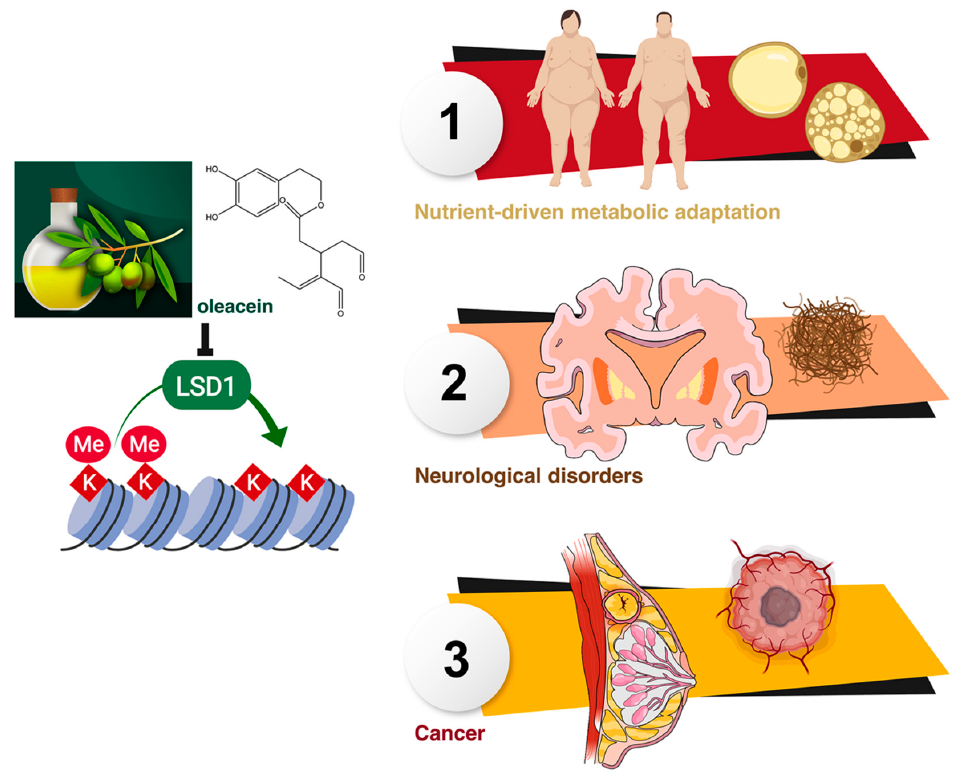
Figure 6. Oleacein-targeted LSD1: A new health-promoting mechanism of extra virgin olive oil (EVOO) phenolics.